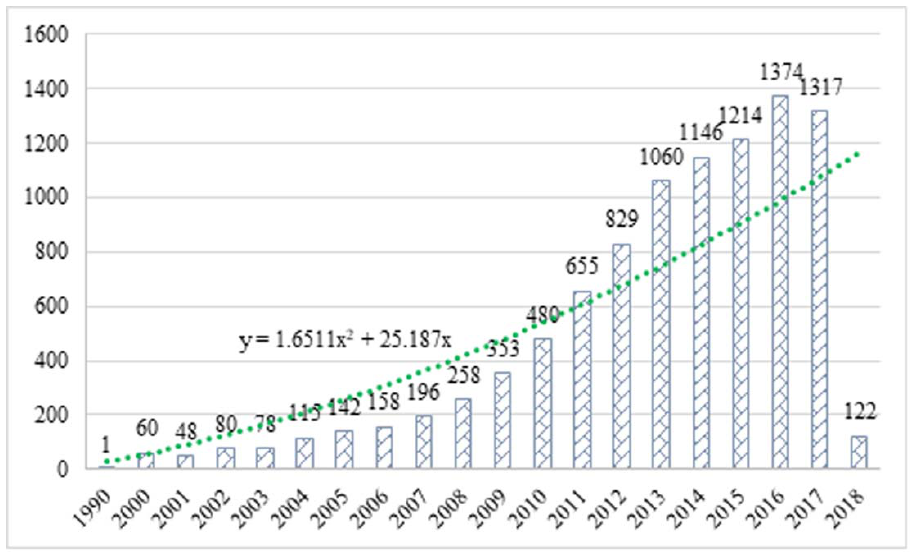
Figure 2. Annual number of publications in the carbon capture and storage (CCS) technology area.